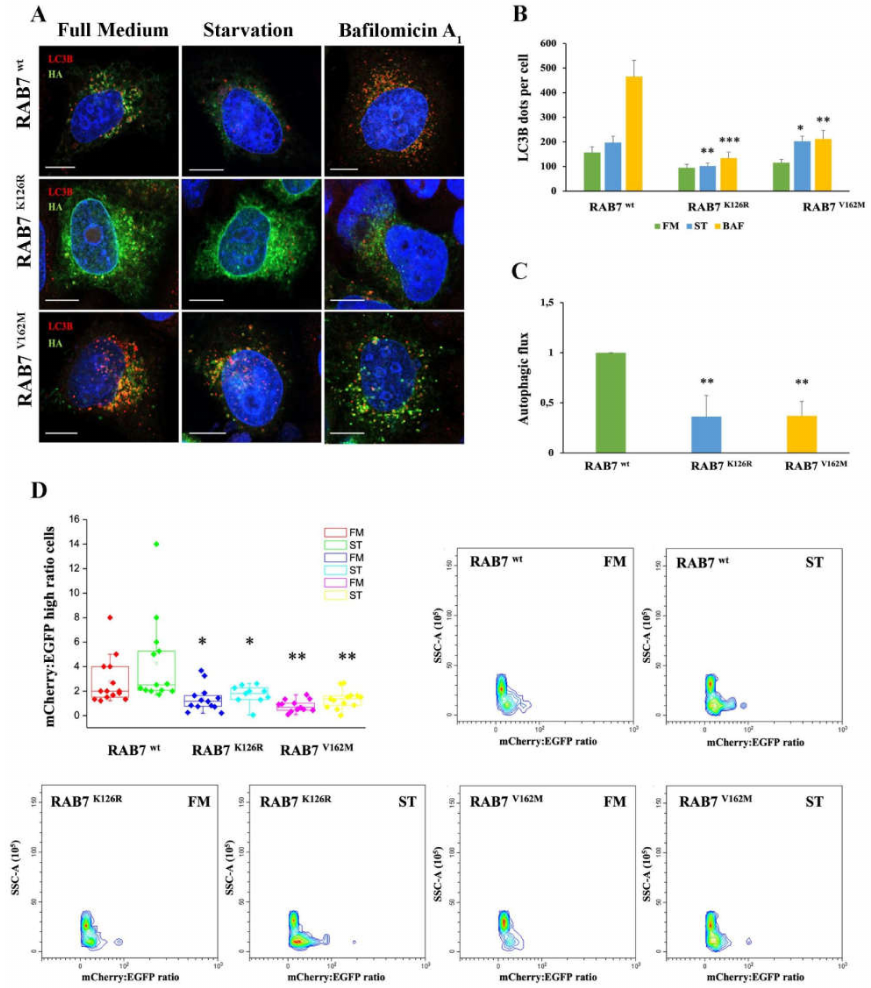
Figure 3. Analysis of autophagy in HeLa cells expressing RAB7 K126R and RAB7 V162M mutant proteins. ( A ) HeLa cells transfected for 48h with plasmids encoding HA-tagged RAB7 wt and CMT2B-causing RAB7 mutants (RAB7 K126R and V162M ) were incubated in full medium (FM) or starvation medium (ST) for 30 min or in the presence of 400 nM bafilomycin A 1 (BAF) for 3 h. LC3B and HA-RAB7 proteins were identify using antibodies against LC3B (red) and HA (green), respectively. Nuclei were stained with DAPI (blue). ( B ) The number of LC3B-positive dots per cell was evaluated for each sample. ( C ) The autophagic flux was calculated as the ratio of LC3B dots between BAF and FM of the same sample. Scale bar = 10 µ m. ( D ) HeLa cells co-transfected for 48 h with EGFP-mCherry-LC3B and with plasmids encoding HA-tagged RAB7 wt and CMT2B-causing RAB7 mutants (RAB7 K126R and V162M ) were incubated with full medium (FM) and starvation medium (ST) for 4 h. Scatter and singlet gates were used to eliminate debris, dead cells and mitotic cells. For each experiment, voltages and gain on EGFP and mCherry detectors are set empirically on negative and positive controls to allow the best plot fit on the mCherry and EGFP ratio histogram. Flow cytometry pseudo color plots of mCherry:EGFP ratio are reported. Statistical t -test analysis was performed between the same conditions (FM, ST and BAF) selecting RAB7 wt as the referring sample. All statistical comparisons are from the sample indicated with asterisks and RAB7 wt . Values are the mean ± SE of three different and independent experiments. * p < 0.05; ** p < 0.01; *** p <